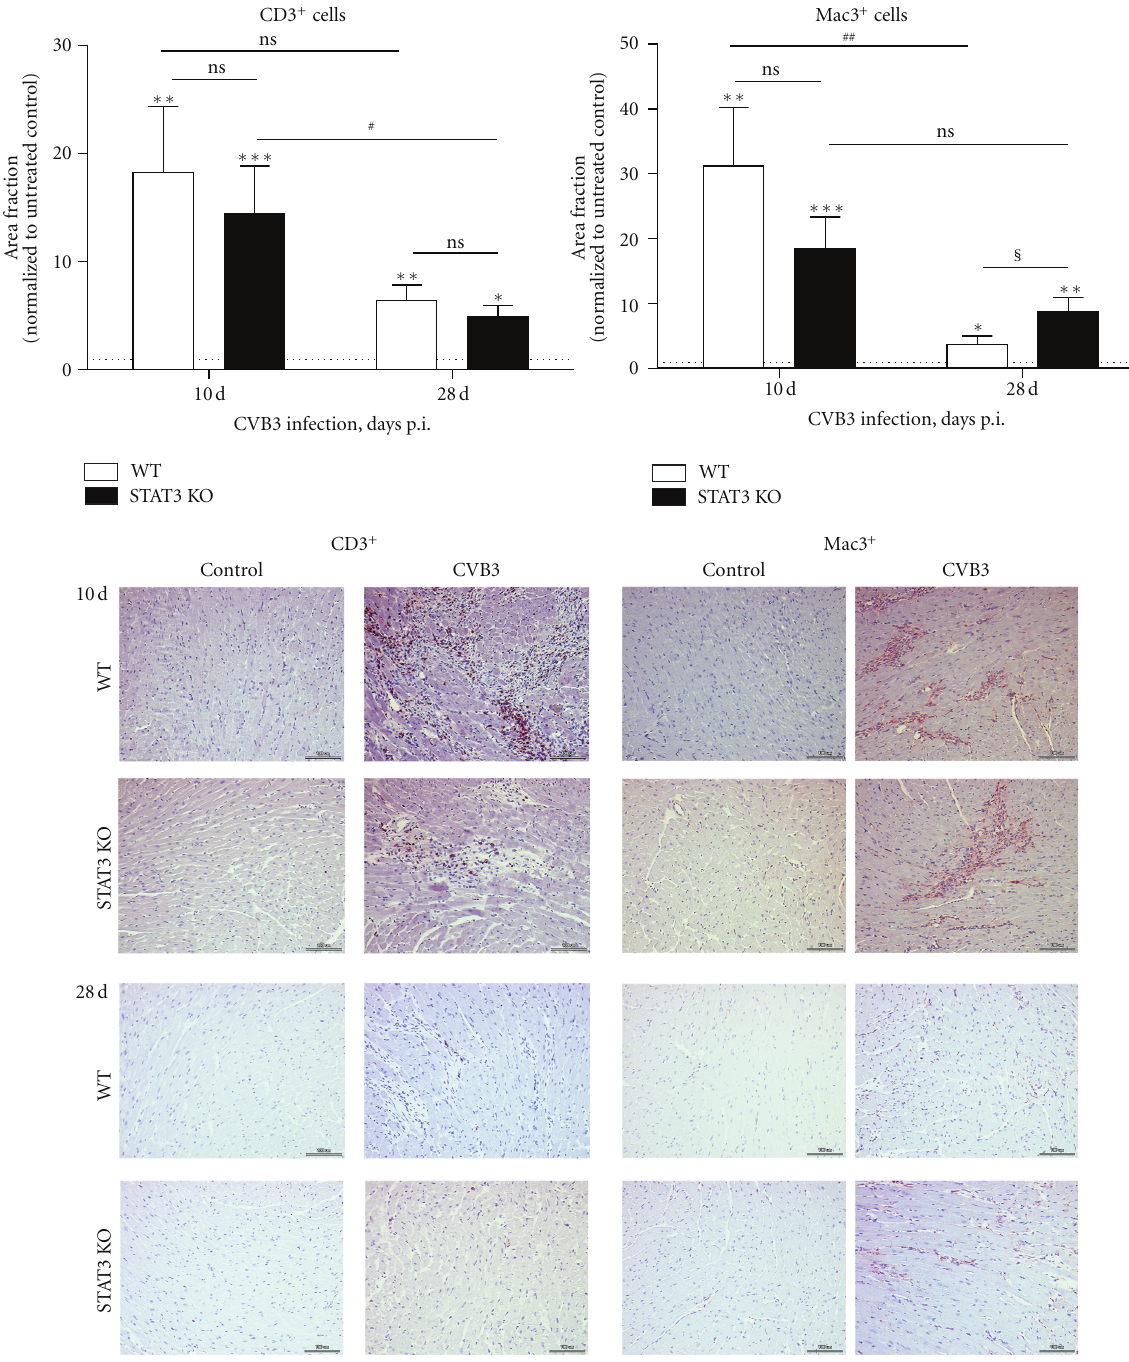
Figure 2: Cell infiltration in cardiac tissue 10 and 28 days after CVB3 infection. Data are expressed as area fraction of tissue sections after staining with antibodies directed against CD3 or Mac3. Data were normalized to corresponding untreated controls and expressed as x-fold over basal level. ∗ Data were compared to the corresponding untreated controls. ∗ P < 0 . 05; ∗∗ P < 0 . 01; ∗∗∗ P < 0 . 001. § Data between WT and STAT3 KO mice were compared. § P < 0 . 05. # Data between 10 or 28 days were compared. # P < 0 . 05; ## P < 0 . 01.